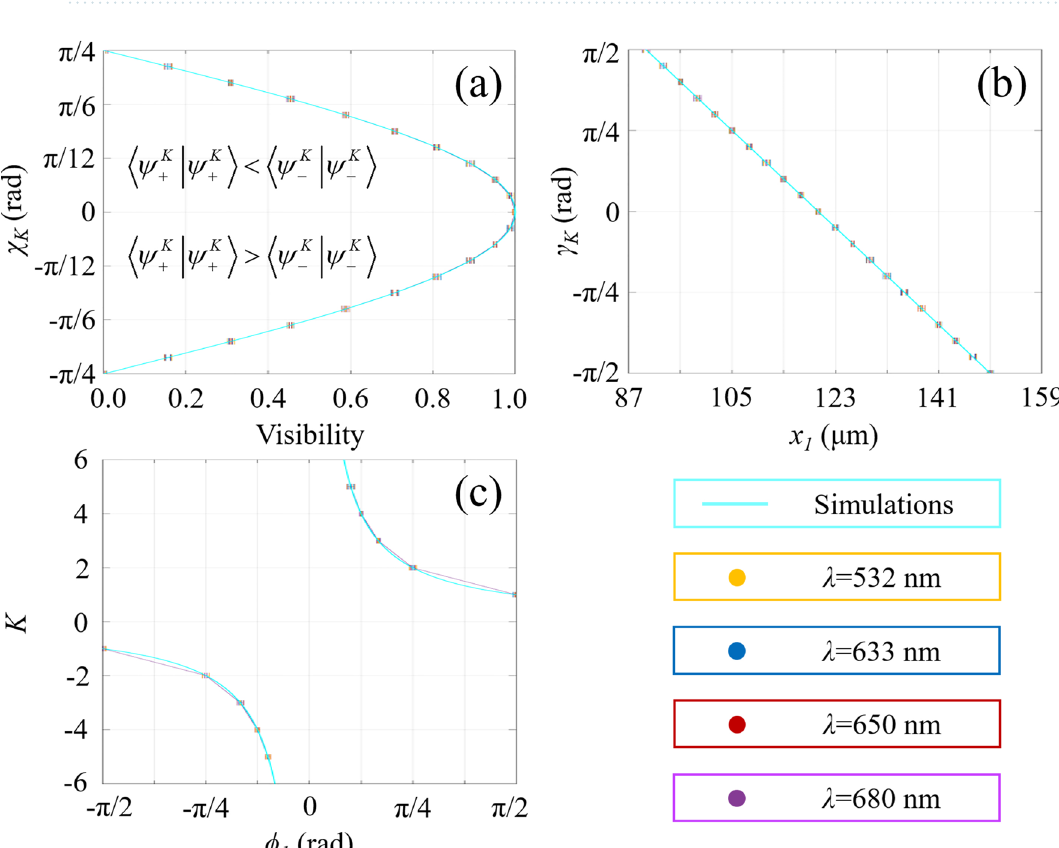
Figure 9. Theoretical simulations (curves) and experimental results (error bars) of single-shot detection of vector vortex states. Total angular momentum sorting under different conditions of wavelengths keeps the same in terms of the proposed